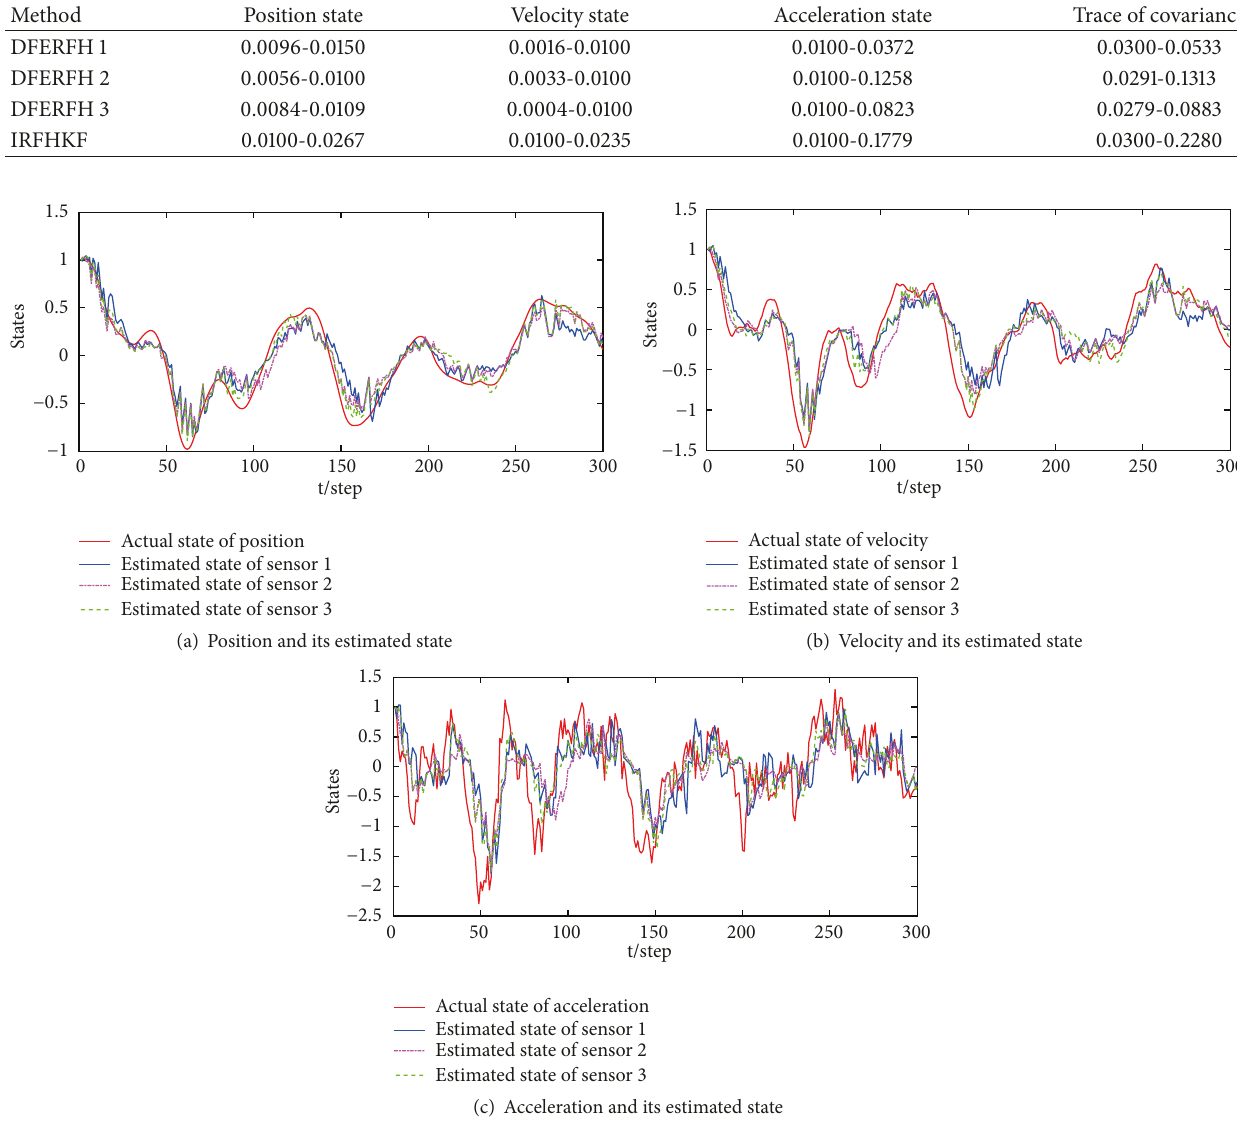
Figure 4: Comparison of distributed estimation results using logic